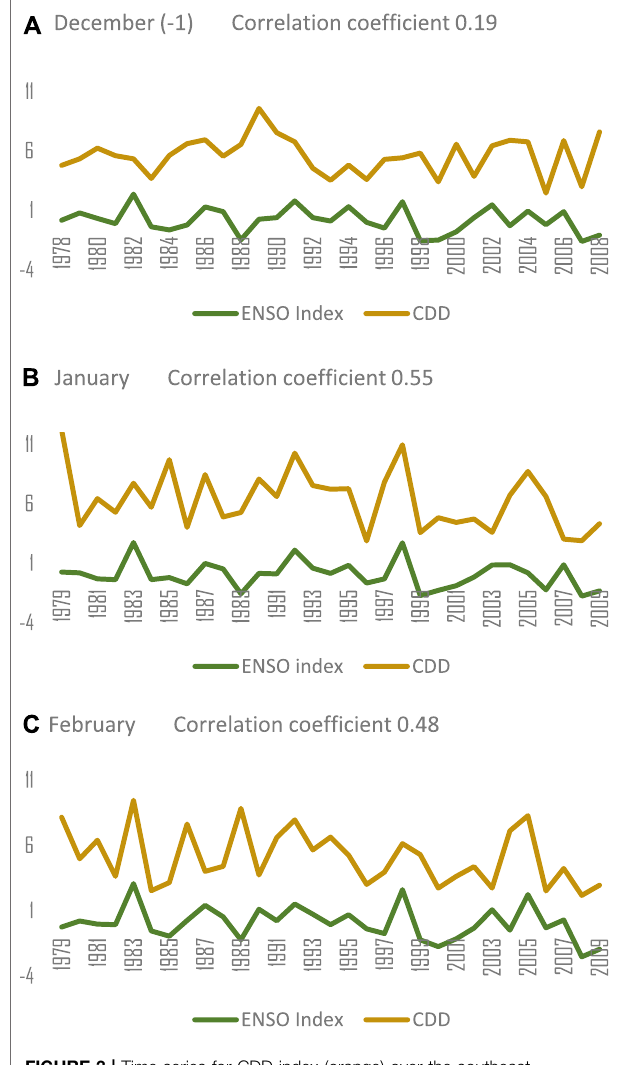
FIGURE 3 | Time series for CDD index (orange) over the southeast Philippines and ENSO index (blue) in (A) December, (B) January, and (C)